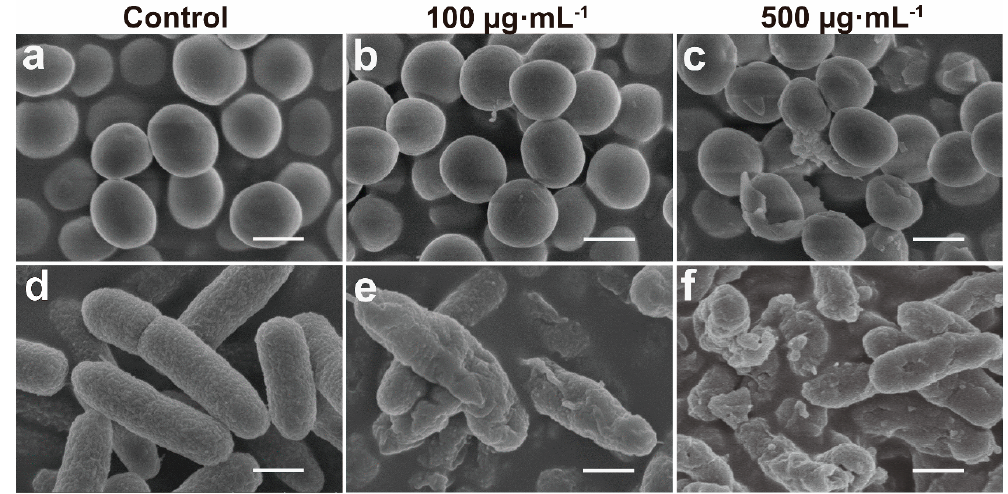
Figure 6. SEM images of ( a – c ) MRSA and ( d – f ) P. aeruginosa after various treatments (Scale bar: 1 µm).